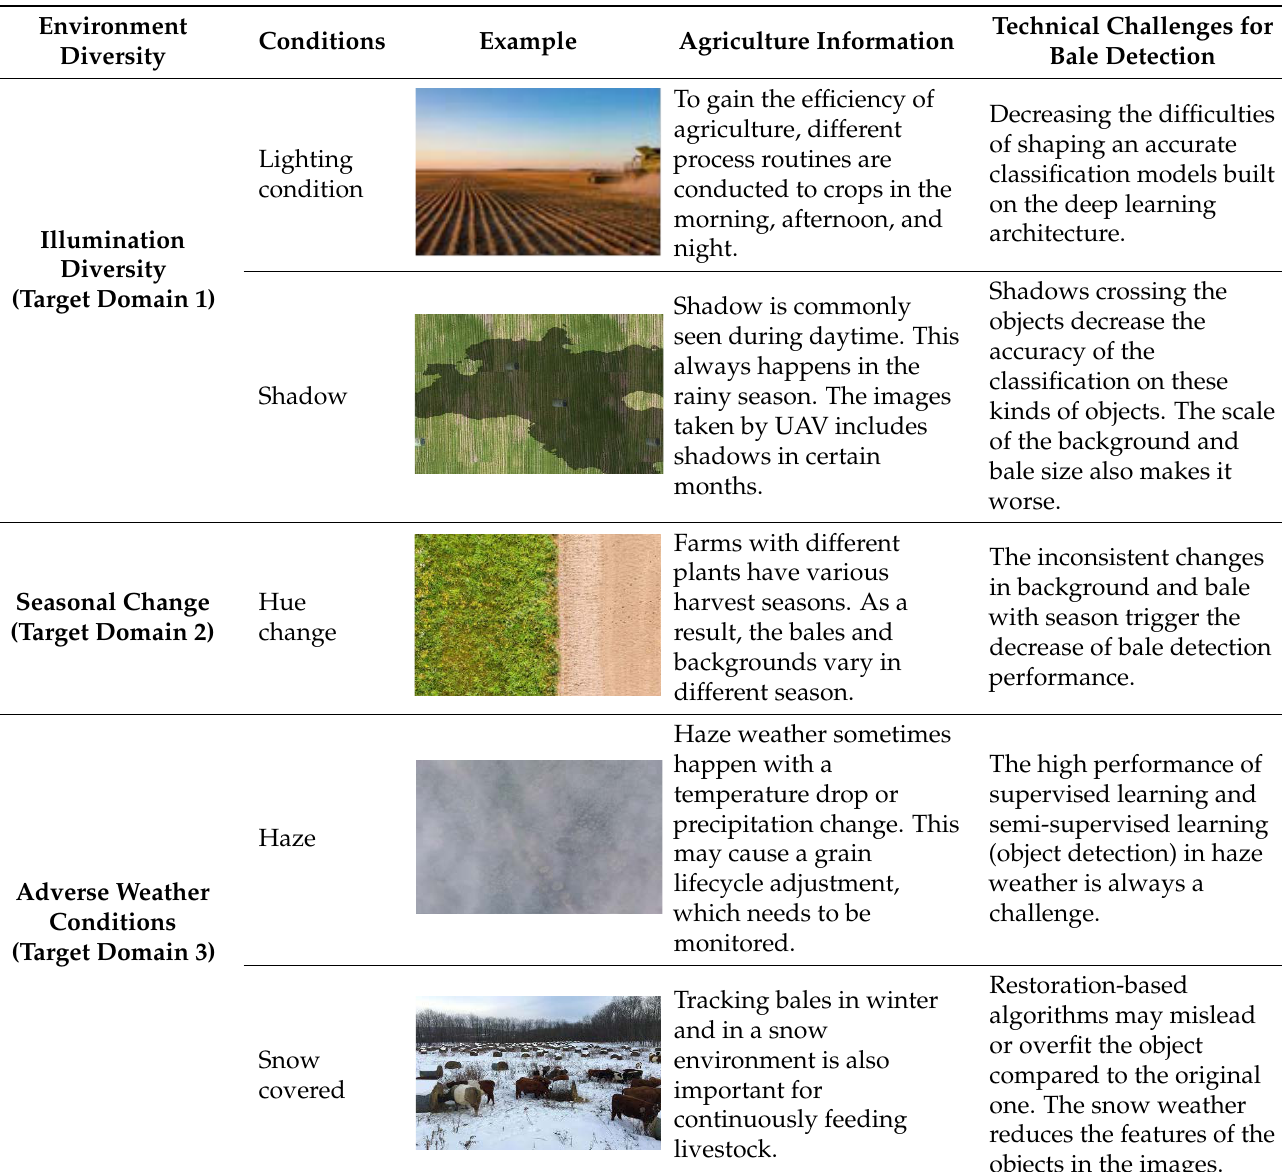
Table 1. Object detection challenges in complex unconstrained outdoor environments.